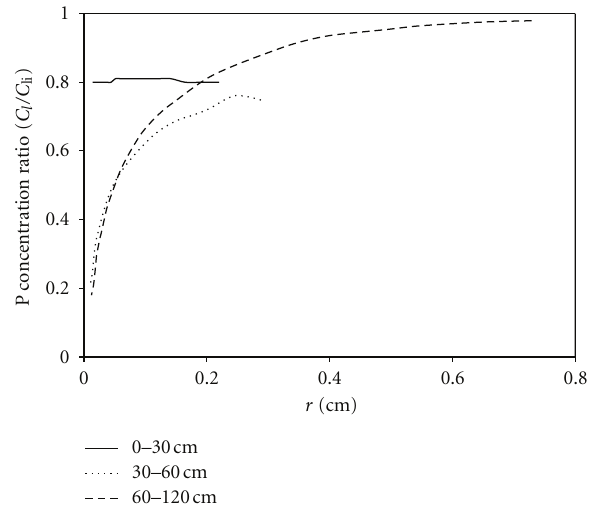
Figure 2: E ff ect of the distance from the root surface, as defined by the r 1 value, on the ratio of the final solution concentration to the initial solution concentration ( C l /C li ) of P for the 0–30, 30–60, and 60–120 cm soil depths in the smooth brome cover